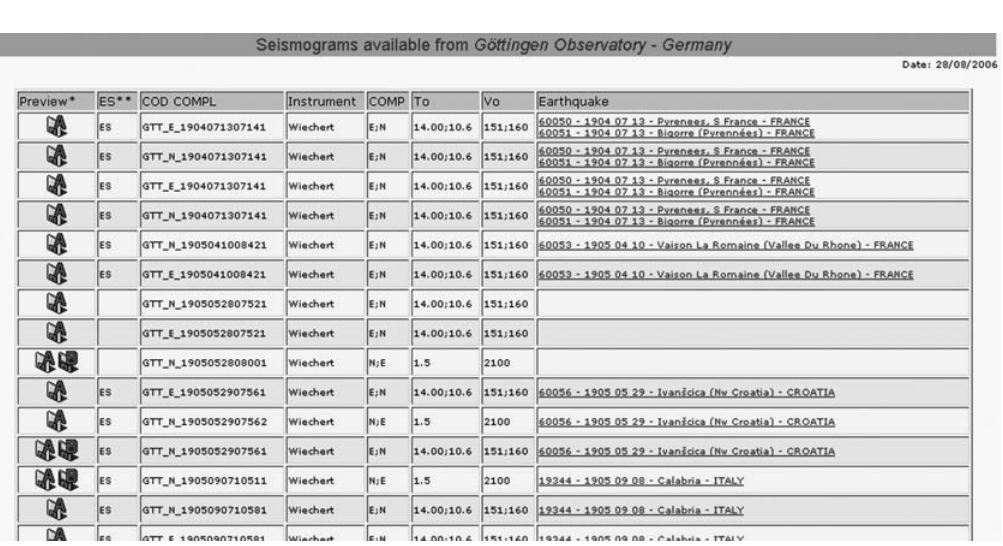
Fig. 11. «Collection» section of the ES Website with progressive updating of the phases that have affected the seismograms coming from the different partner countries involved in the project.